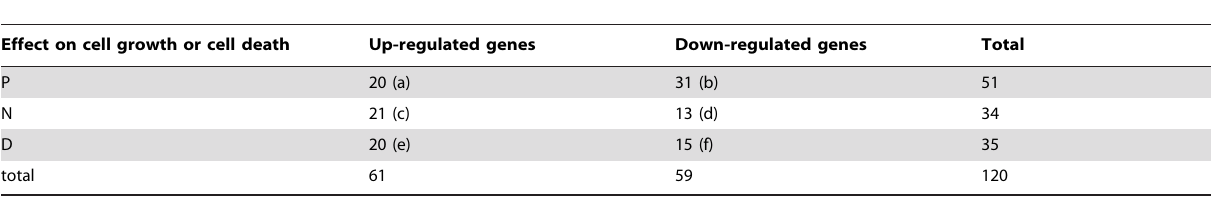
Table 2. Effect miR-34a induced genes on cell growth and cell